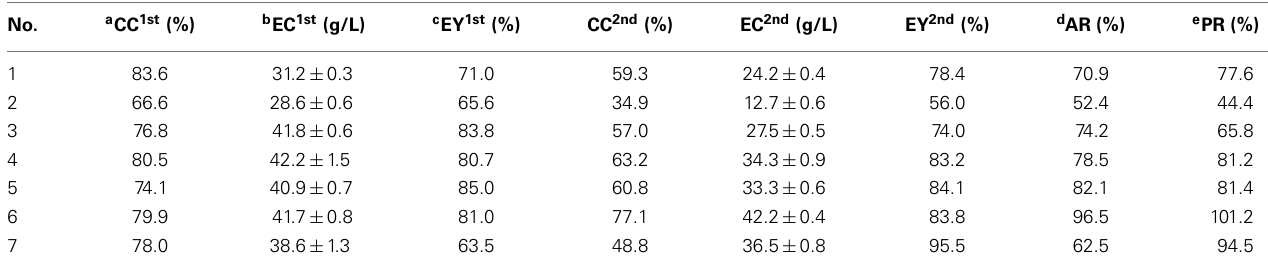
Table 3 | Summary of cellulose conversion rates, ethanol concentrations, and yields with different operating conditions for a single enzyme recycling run